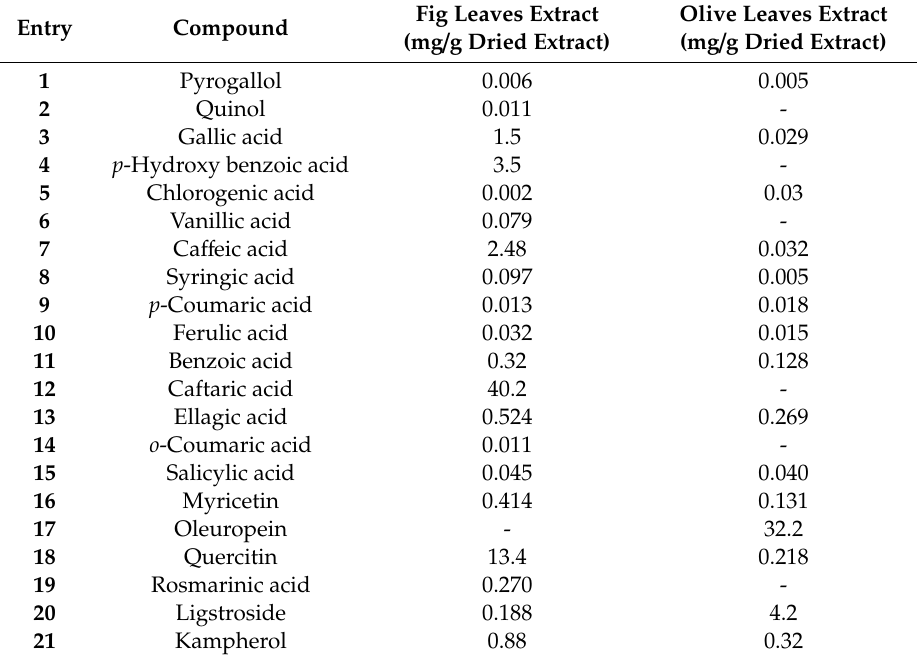
Table 5. HPLC analysis of extracts of the phenolic compounds of FLE and